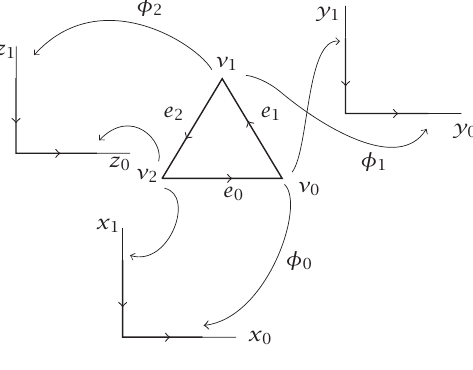
Figure 7.1 . Differential forms on S 1